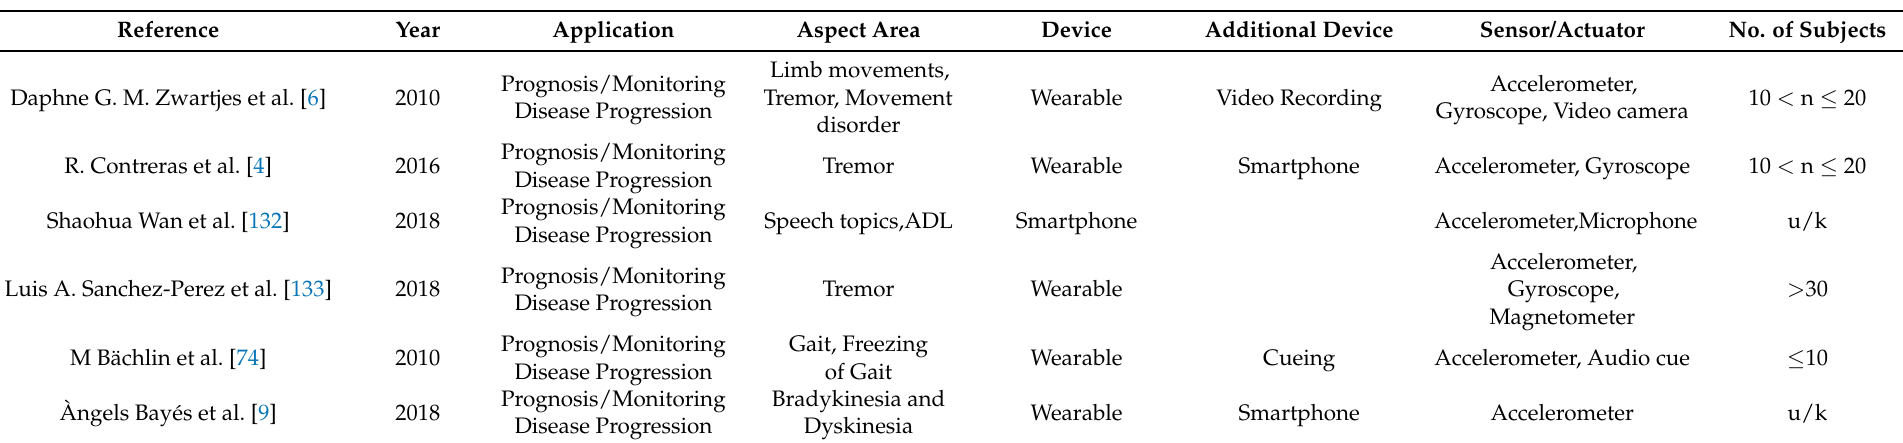
Table A3. Papers about prognosis or monitoring of disease progression and severity of